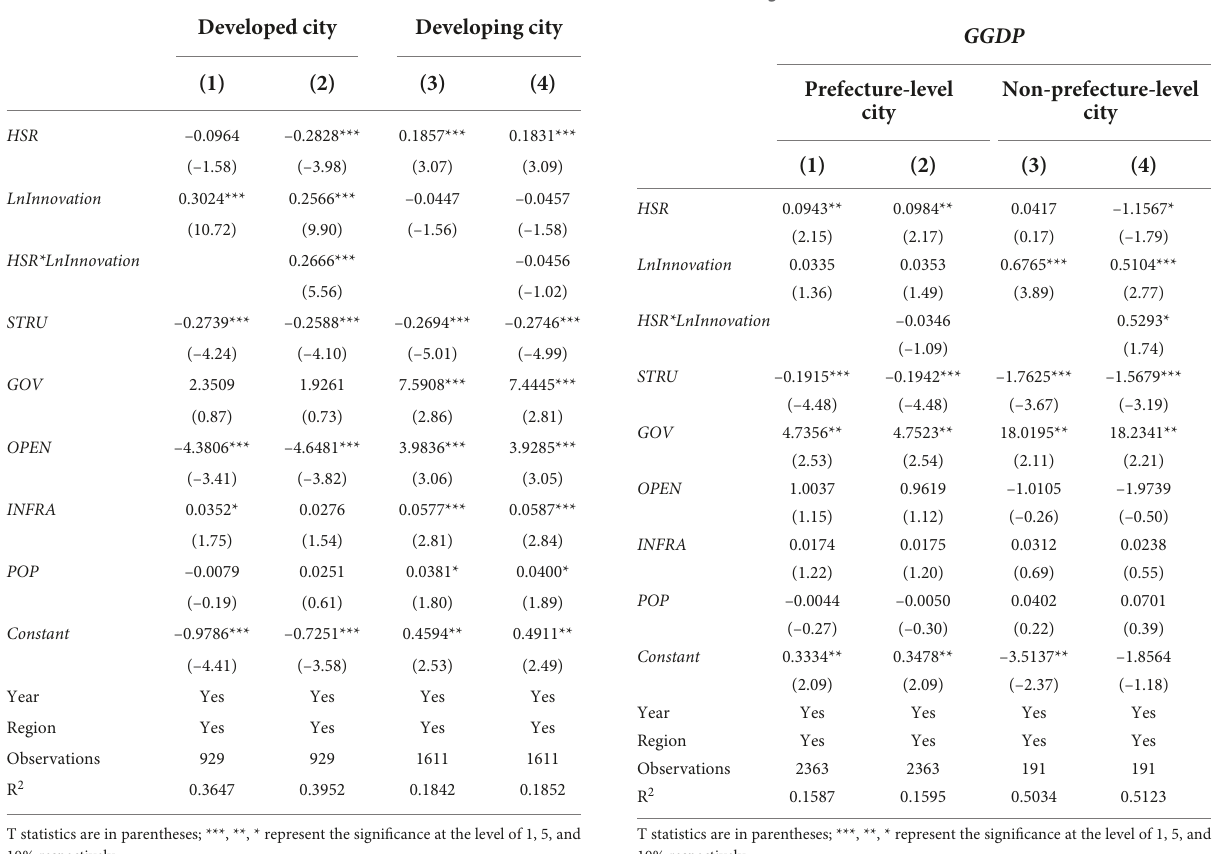
TABLE 7 The regression results of administrative